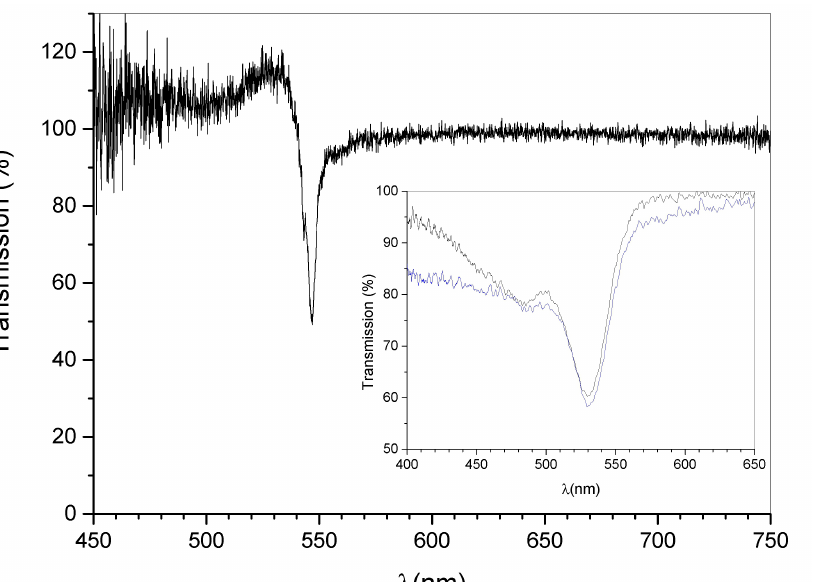
Figure 1. Transmission spectrum showing the normalized reflection peak at the end of the recording process. The normalization is performed outside the grating area. This explains a transmission higher than 100% in the first region of the spectrum. In the inset we report, in black, the transmission spectrum of the polymerized free-standing film and, for comparison, in blue, the transmission spectrum of the flexible polymerized film confined between the two transparent scotch tape